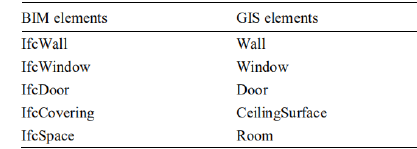
Table 3. Semantic data in IFC organized in GIS